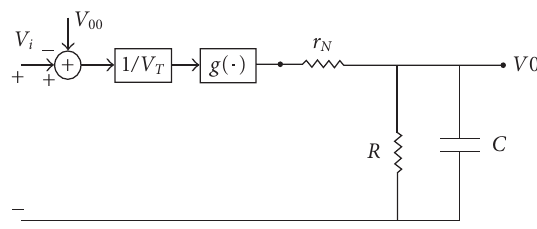
Figure 3.4. First-order perturbation model for diode in half-wave rectifier.